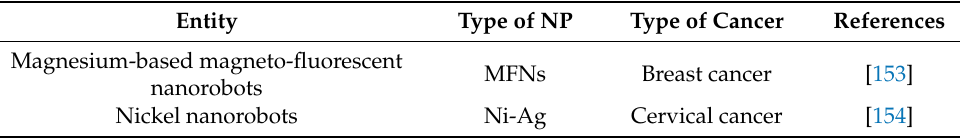
Table 10. Nanotheranostics against types of cancer using magnetic